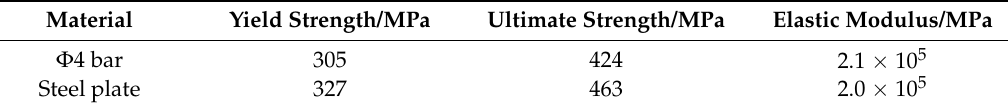
Table 2. Properties of steel.